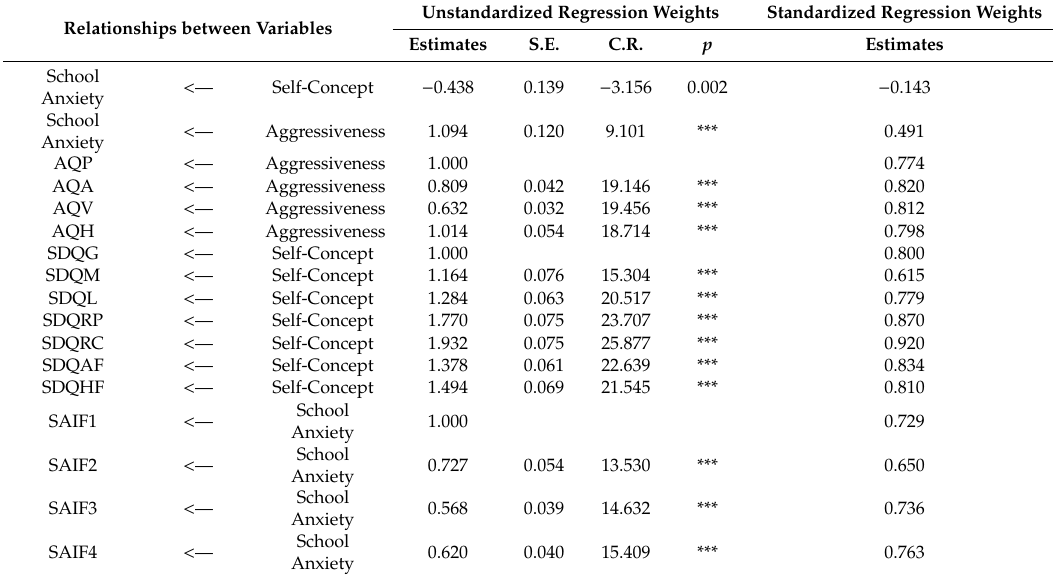
Figure 2. Structural equations model. Note: SAIF1: Anxiety related to assessment and academic failure; SAIF2: Anxiety related to victimization; SAIF3: Anxiety related to social assessment; SAIF4: Anxiety related to scholastic punishment; AQH: Hostility; Hostility; AQV: Verbal aggression; AQA: Anger; AQP: Physical aggression; SDQHF: Physical ability; SDQAF: Physical appearance; SDQRC: Relationship with peers; SDQRP: Relationship with parents; SDQG: General self-concept. Table 2. Structural model